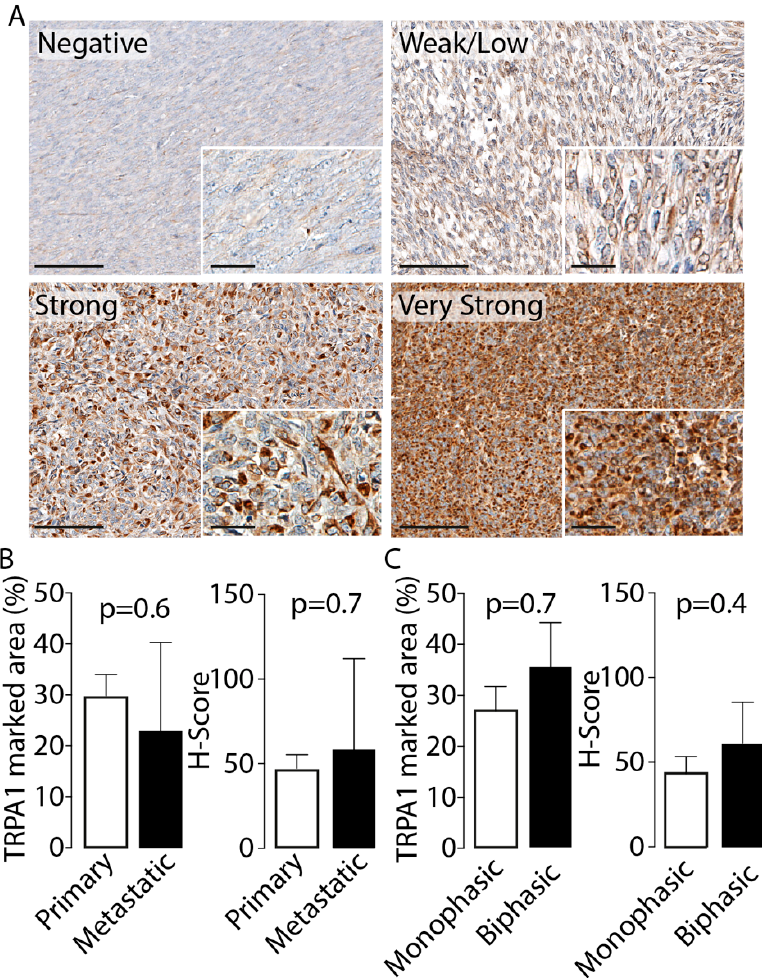
Figure 1. ( A ). Representative photomicrographs of transient receptor potential ankyrin 1 (TRPA1) staining intensity (negative, weak/low, strong and very strong) in synovial sarcoma (SS) samples. Cumulative data of TRPA1 marked area (%) and H-Score in ( B ) primary and metastatic and ( C ) monophasic and biphasic SS samples ( C ). Data are reported as mean ± SD, Student’s t-test. Magnification ×200, inset ×400 (Scale bars: 100 μ m, inset 20 μ m).